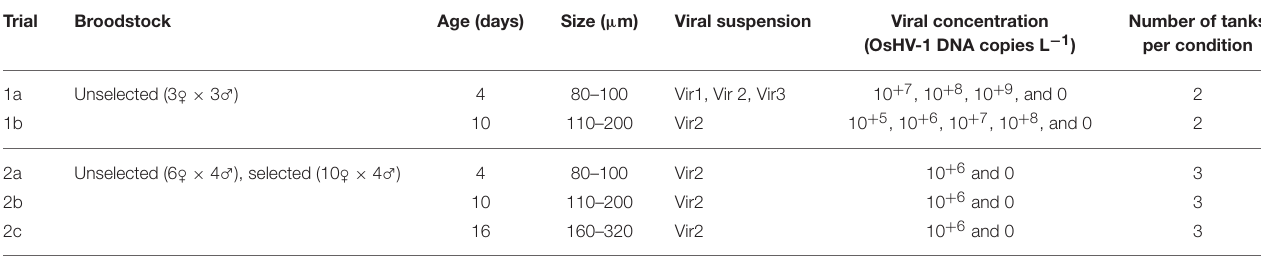
TABLE 1 | Summary of experimental OsHV-1 infections in C. gigas larvae.